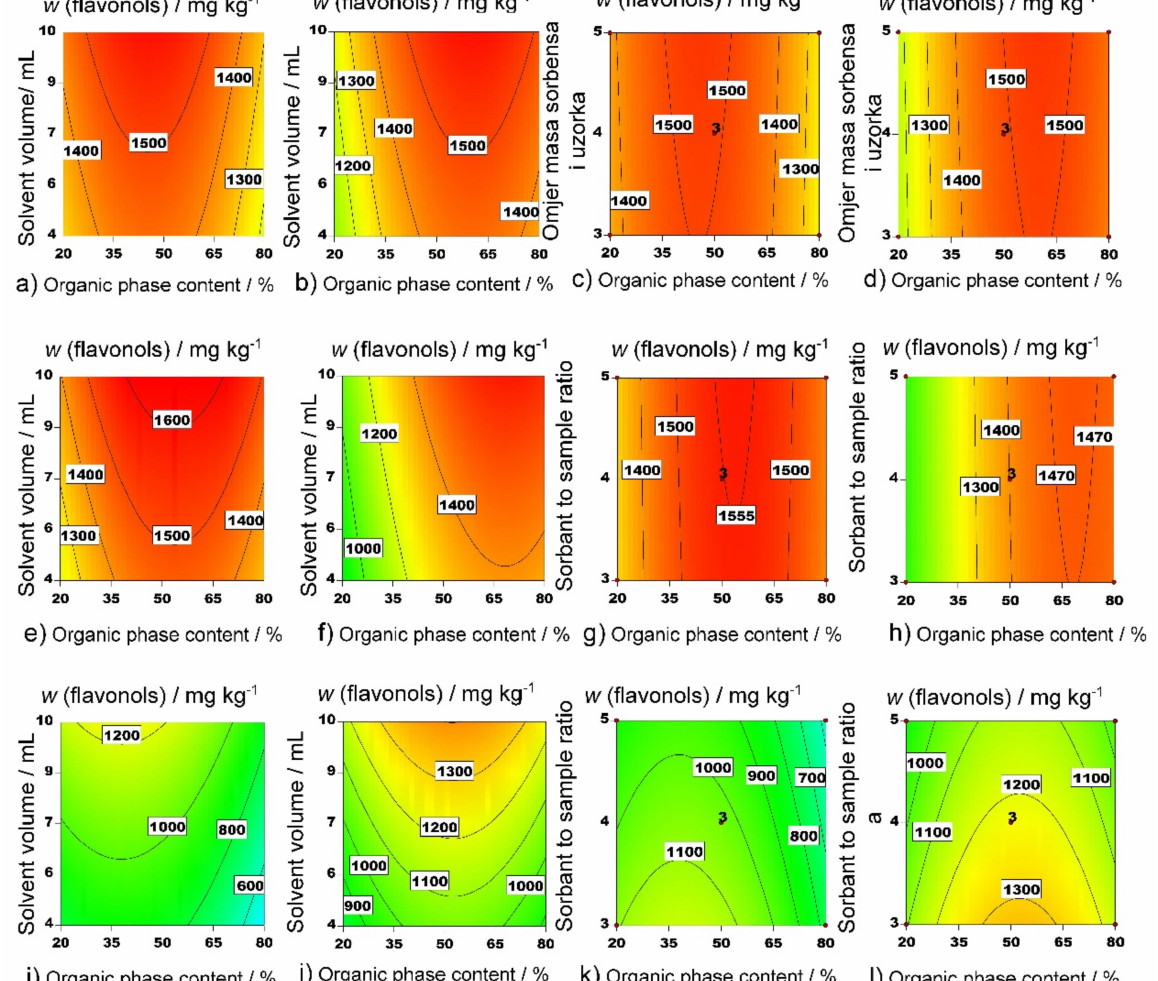
Figure 6. Contour plots of the most significant interaction effects between individual extraction factors on the content of flavonols when using ( a ) sea sand and acetonitrile and ( b ) sea sand and ethanol with a sorbent-to-sample ratio of 4:1, ( c ) sea sand and acetonitrile and ( d ) sea sand and ethanol with an elution solvent volume of 7 mL, ( e ) phenyl silica and acetonitrile and ( f ) phenyl silica and ethanol with a sorbent to sample ratio of 4:1, ( g ) phenyl silica and acetonitrile and ( h ) phenyl silica and ethanol with an elution solvent volume of 7 mL, ( i ) XAD-2 and acetonitrile and ( j ) XAD-2 and ethanol with a sorbent to sample ratio of 4:1, and ( k ) XAD-2 and acetonitrile and ( l ) XAD-2 and ethanol with an elution solvent volume of 7